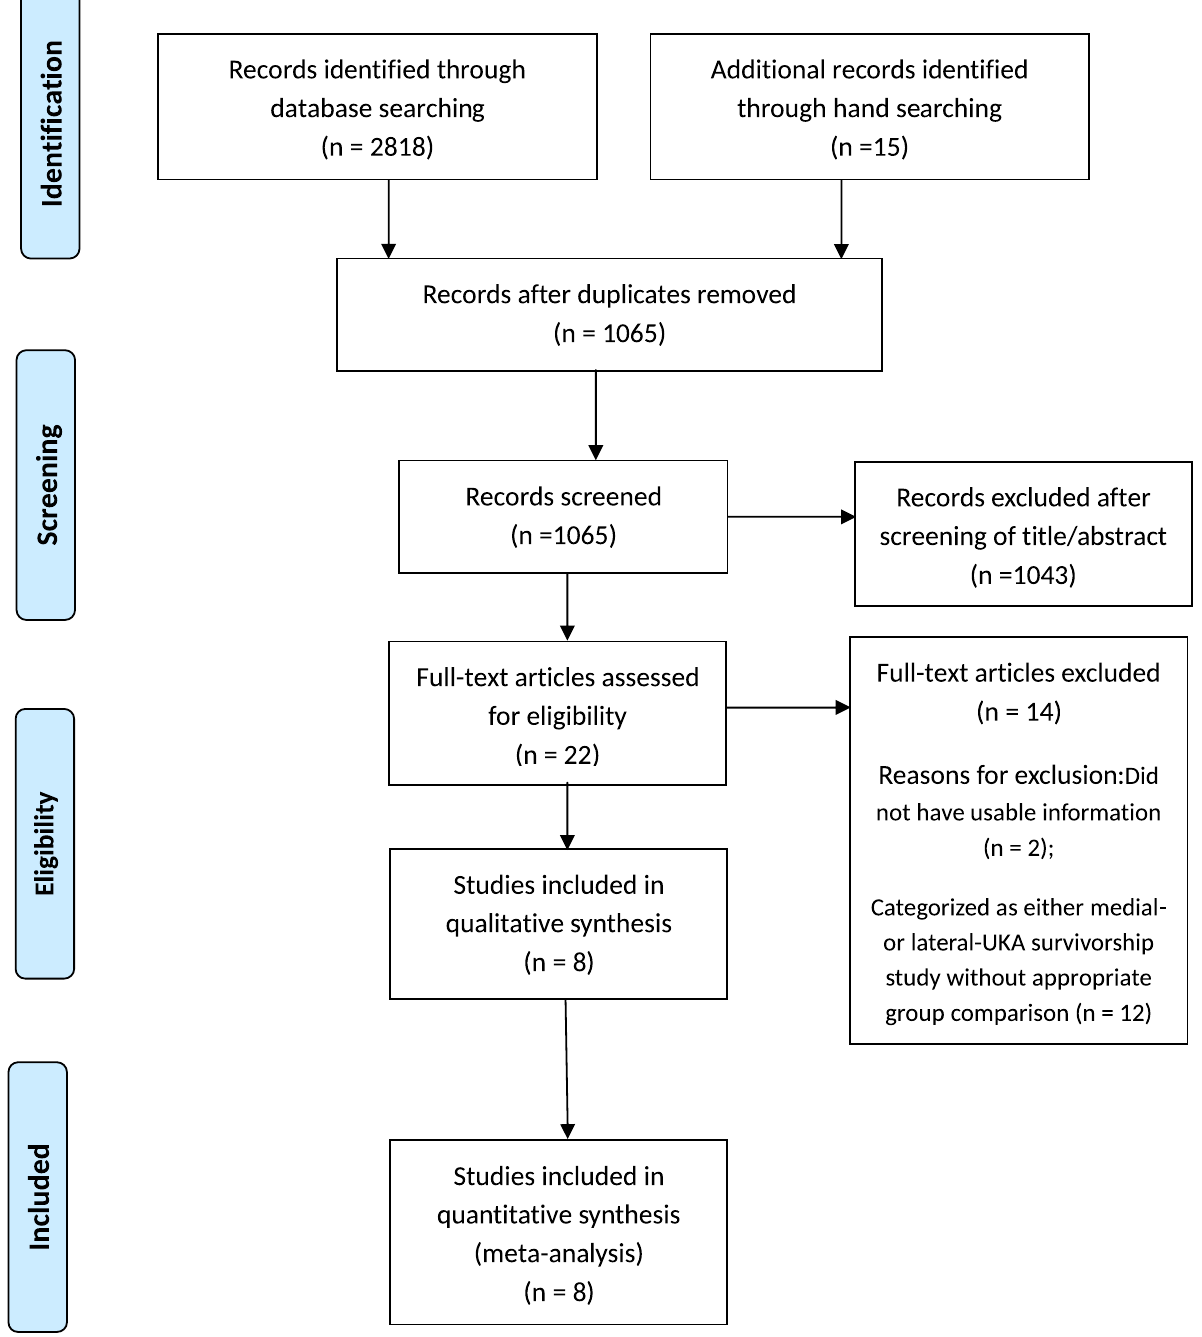
Fig 1. A flow diagram of preferred reporting items for systemic reviews and meta-analyses